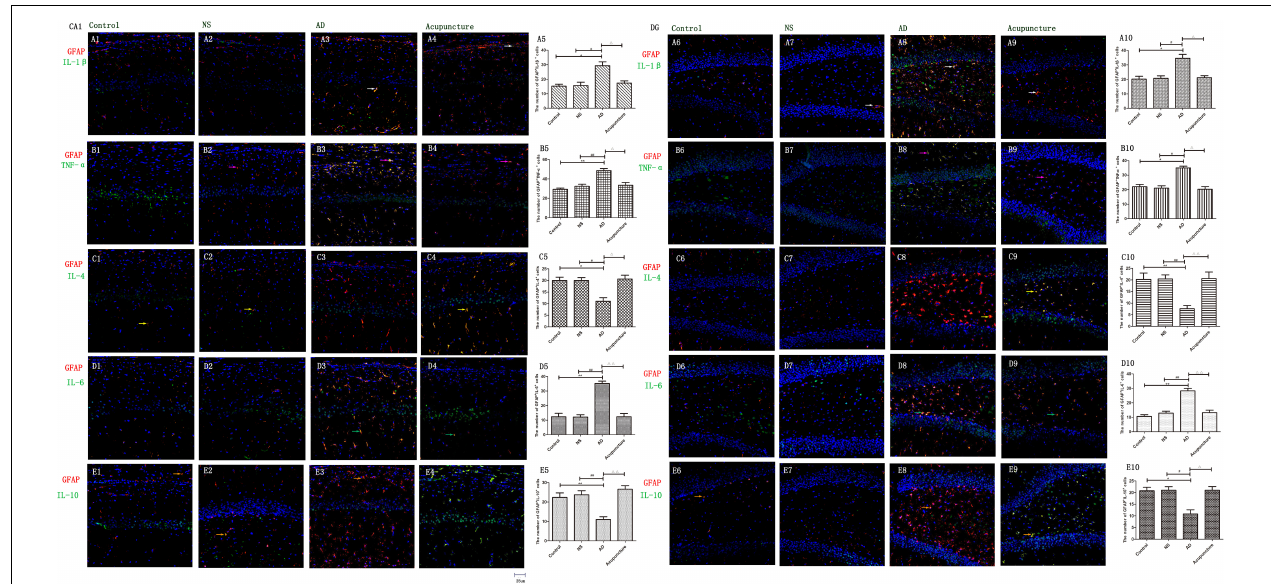
FIGURE 5 | The astrocytic cytokines in different groups. The astrocytic cytokines were double-stained with cytokine antibodies and anti-GFAP antibody. (A1–4) Double staining with IL-1 β and GFAP (CA1 area). (A6–9) Double staining with IL-1 β and GFAP (DG area). (B1–4) TNF- α and GFAP (CA1 area). (B6–9) TNF- α and GFAP (DG area). (C1–4) IL-4 and GFAP (CA1 area). (C6–9) IL-4 and GFAP (DG area). (D1–4) IL-6 and GFAP (CA1 area). (D6–9) IL-6 and GFAP (DG area). (E1–4) IL-10 and GFAP (CA1 area). (E6–9) IL-10 and GFAP (DG area). (Red expresses GFAP-positive cells, green expresses cytokine-positive cells, and blue expresses DAPI. The white arrow expresses IL-1 β + GFAP + cells. The pink arrow expresses TNF- α + GFAP + cells. The yellow arrow expresses IL-4 + GFAP + cells. The green arrow expresses IL-6 + GFAP + cells. The Beige arrow expresses IL-10 + GFAP + cells.) (A5,B5,C5,D5,E5,A10,B10,C10,D10,E10) The number of positive double-stained cells in different groups. Error bars: SE. Compared with Control group, * p < 0.05, ** p < 0.01; compared with NS group, # p < 0.05, ## p < 0.01; compared with AD group, (cid:77) p < 0.05, (cid:77)(cid:77) p < 0.01 ( n = 5).